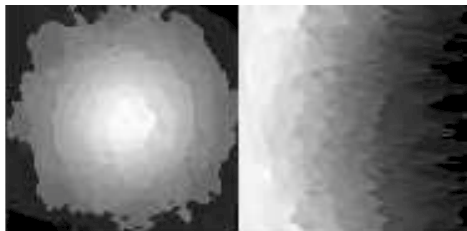
Figure 8: From left to right: Detected tower region in the height map in Cartesian and polar coordinates